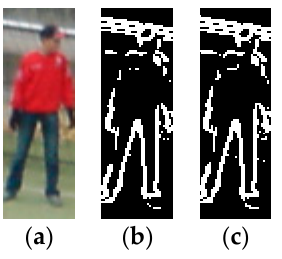
Figure 1. Reconstructed human image from CENTRIST. ( a ) Original image; ( b ) Contour image; ( c ) Reconstruct image.